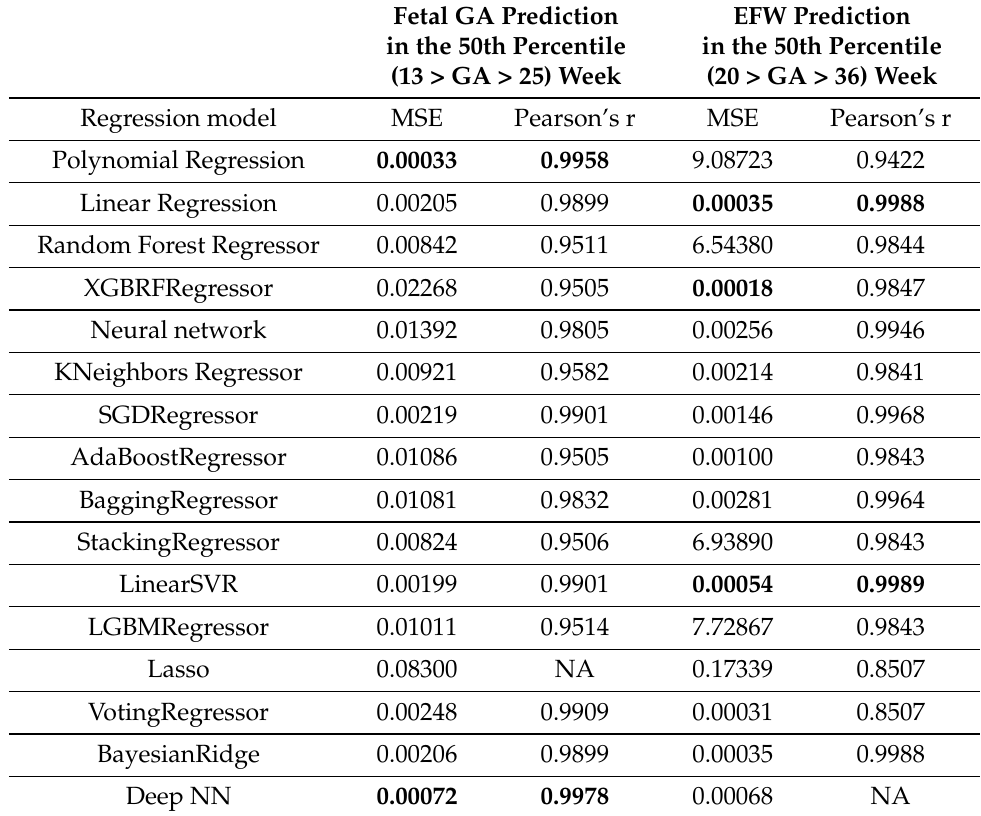
Table 11. Result and validation of multiple regression models for GA and EFW prediction. Fetal GA